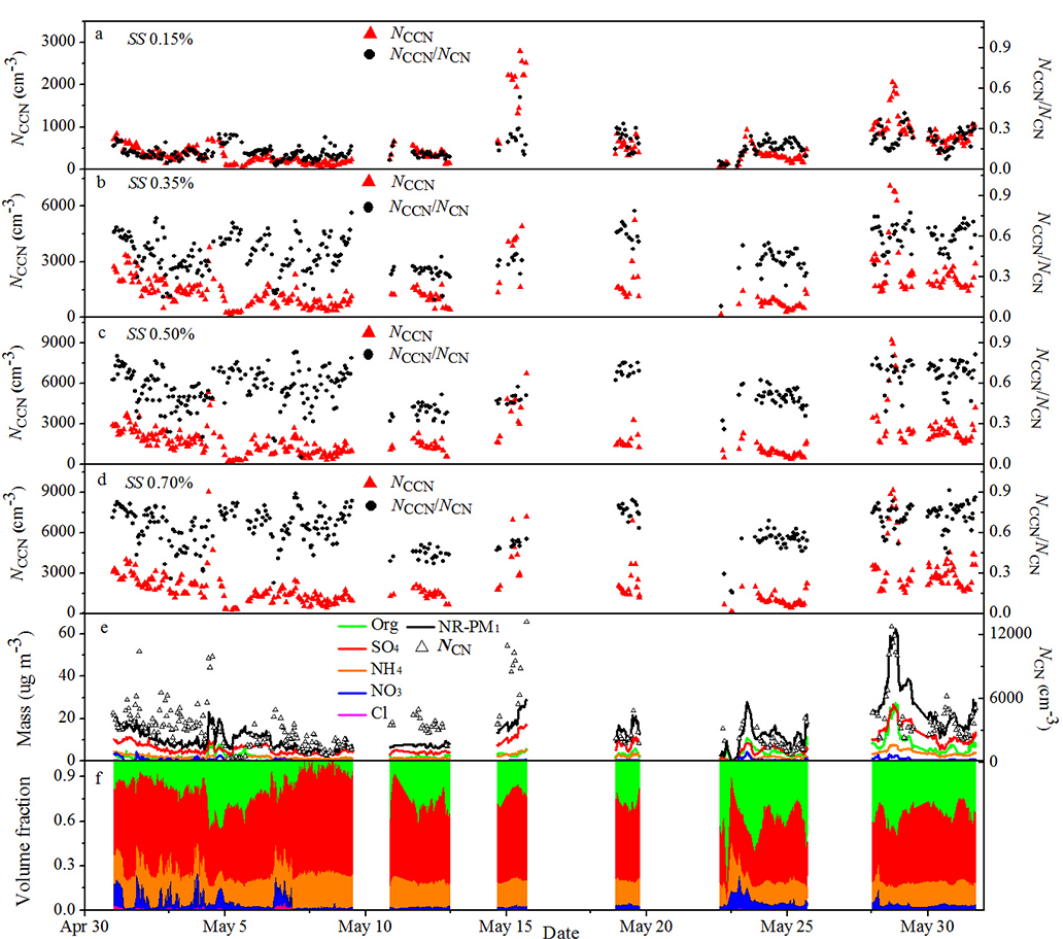
Figure 2. The N CCN and the N CCN /N CN ratio at SS of (a) 0.15%, (b) 0.35%, (c) 0.50%, and (d) 0.70%; (e) N CN and NR-species mass concentrations from CCNc, SMPS and AMS; (f) NR-species volume fractions derived from AMS.